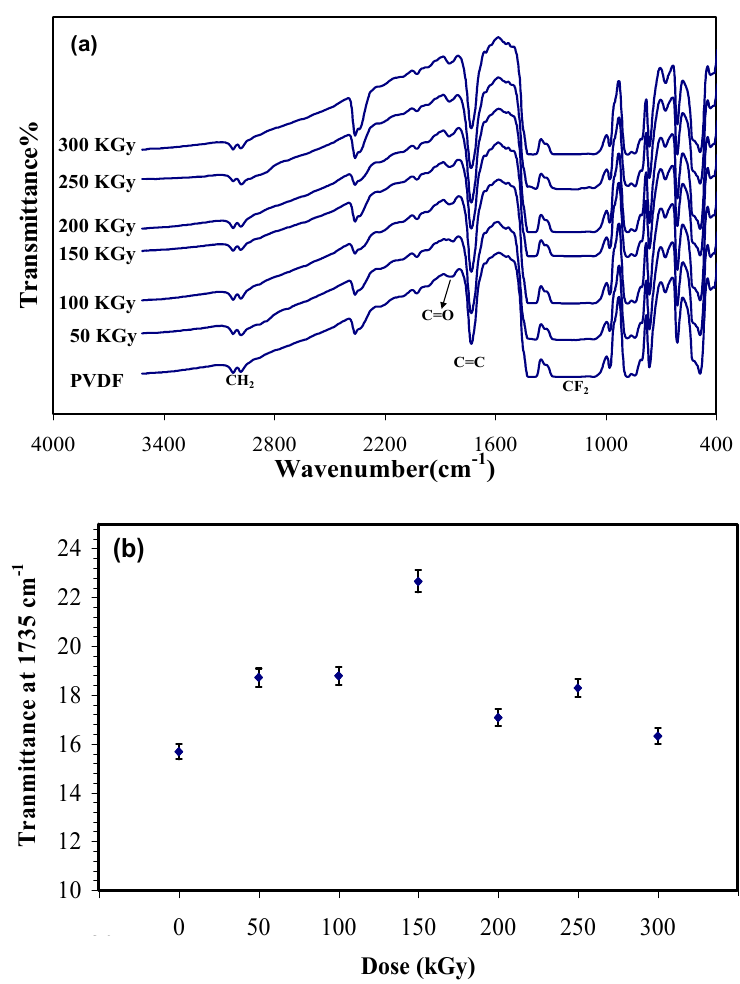
Figure 1. ( a ) Fourier transform infrared spectroscopy (FTIR) spectra of irradiated and unirradiated Polyvinylidene fluoride ( PVDF) membrane; and ( b ) absorbance at 1735 cm − 1 (C=C) versus electron beam (EB) dose in terms of